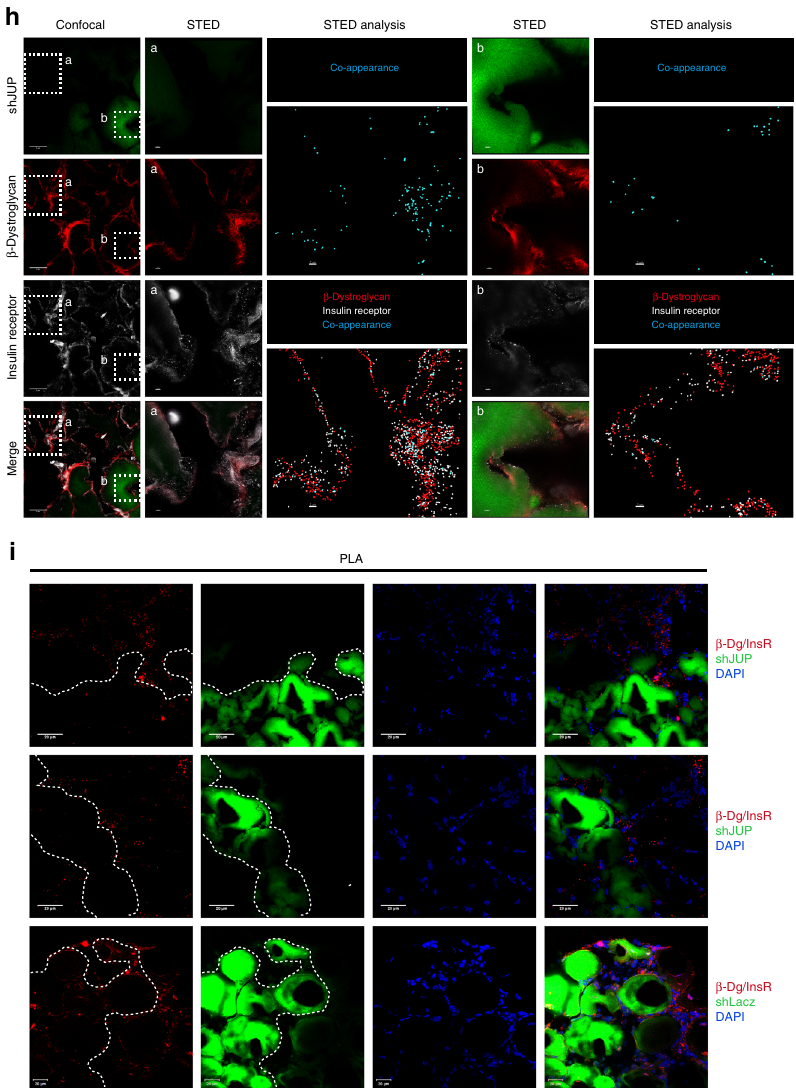
Fig. 3 Plakoglobin downregulation reduces DGC-insulin receptor association and insulin signaling, and causes atrophy. Contralateral muscles from fasted mice were electroporated with plakoglobin shRNA (shJUP) or control shRNA (shLacz). Red rectangle marks fractions containing glycosylated- β - dystroglycan in shLacz-expressing muscles. STED: Stimulated emission depletion microscopy. a Muscle membrane extracts were analyzed by glycerol gradients and immunobloting. n = three independent experiments. b Mice were injected with saline or glucose (1 mg/g body weight) and muscle membrane extracts were analyzed by glycerol gradient and immunoblotting. n = three independent experiments. c Syntrophin immunoprecipitation from muscle membrane extracts from mice injected with saline or glucose (1 mg/g body weight). Precipitates were analyzed by immunoblotting. Right: Densitometric measurements of presented blots. Graph depicts ratio of each protein to syntrophin. n = two independent experiments. d Soluble fractions of transfected muscles from mice injected with saline or glucose were analyzed by immunobloting. n = two independent experiments. e Mean weights of muscles expressing shJUP are plotted as the percentage of shLacz muscles. Data are represented as mean ± SEM. n = 14 mice; * P < 0.00005 by one-tailed t test. n = two independent experiments. f Cross-sectional areas of 521 fi bers expressing shJUP (also express GFP, green bars) vs. 521 non-transfected fi bers (black bars). n = 4 mice. g Top: Representative confocal images of transfected muscles cross-sections (also express GFP), stained with anti-insulin receptor and anti- β -dystroglycan. Bar, 20 μ m. n = two independent experiments. Bottom: Colocalization of β -dystroglycan and insulin receptor in region of interest (the region of co-occurrence, data are presented as ratio to shLacz), and the corresponding Pearson ’ s correlation coef fi cients of colocalization. n = 8, two independent experiments. * P < 0.05 vs. shLacz, by one-tailed t test. Data are represented as mean ± SEM. h Confocal (bar, 5 μ m) and STED (bar, 2 μ m) images of cross-sections of transfected muscles stained with the indicated antibodies. n = two independent experiments. STED analysis was performed using the spots module of the Imaris software for β -dystroglycan and insulin receptor (white and red spheres, respectively). β -Dystroglycan-insulin receptor co-occurrence is in blue. i Proximity ligation assay (PLA) was performed on cross- sections of transfected muscles stained with β -dystroglycan and insulin receptor antibodies. Red fl uorescent dots indicate areas of β -dystroglycan- insulin receptor